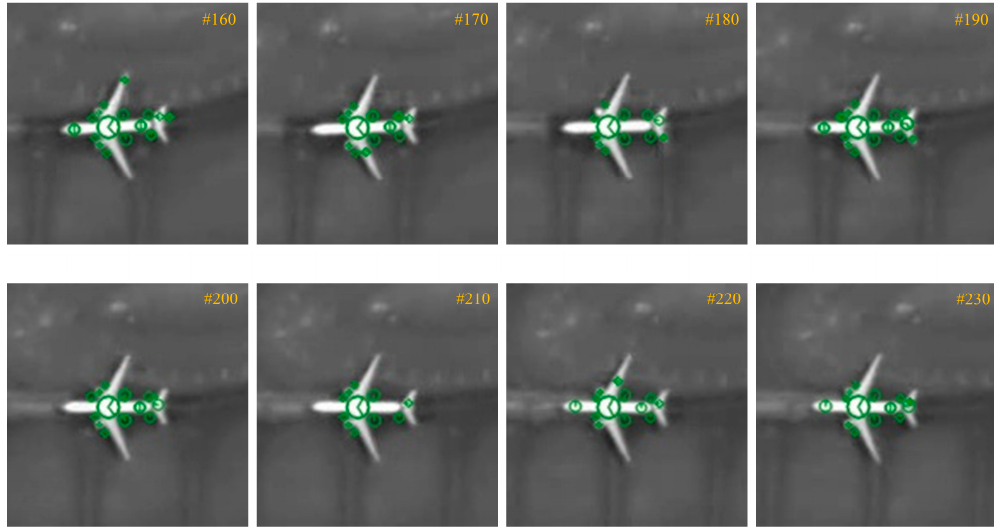
Figure 4. The SIFT keypoints of moving Airplane 8 extracted from different frames. The number in each subfigure represents the frame ID in the test video. Each SIFT keypoint is represented by a circle with an angled radius.